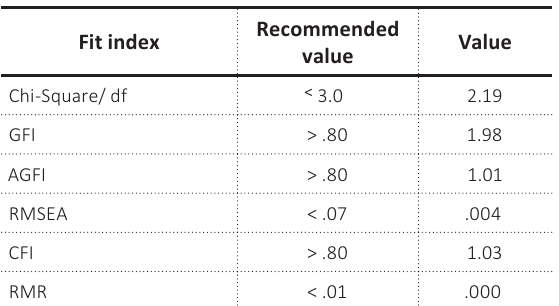
Table 5. Model fit